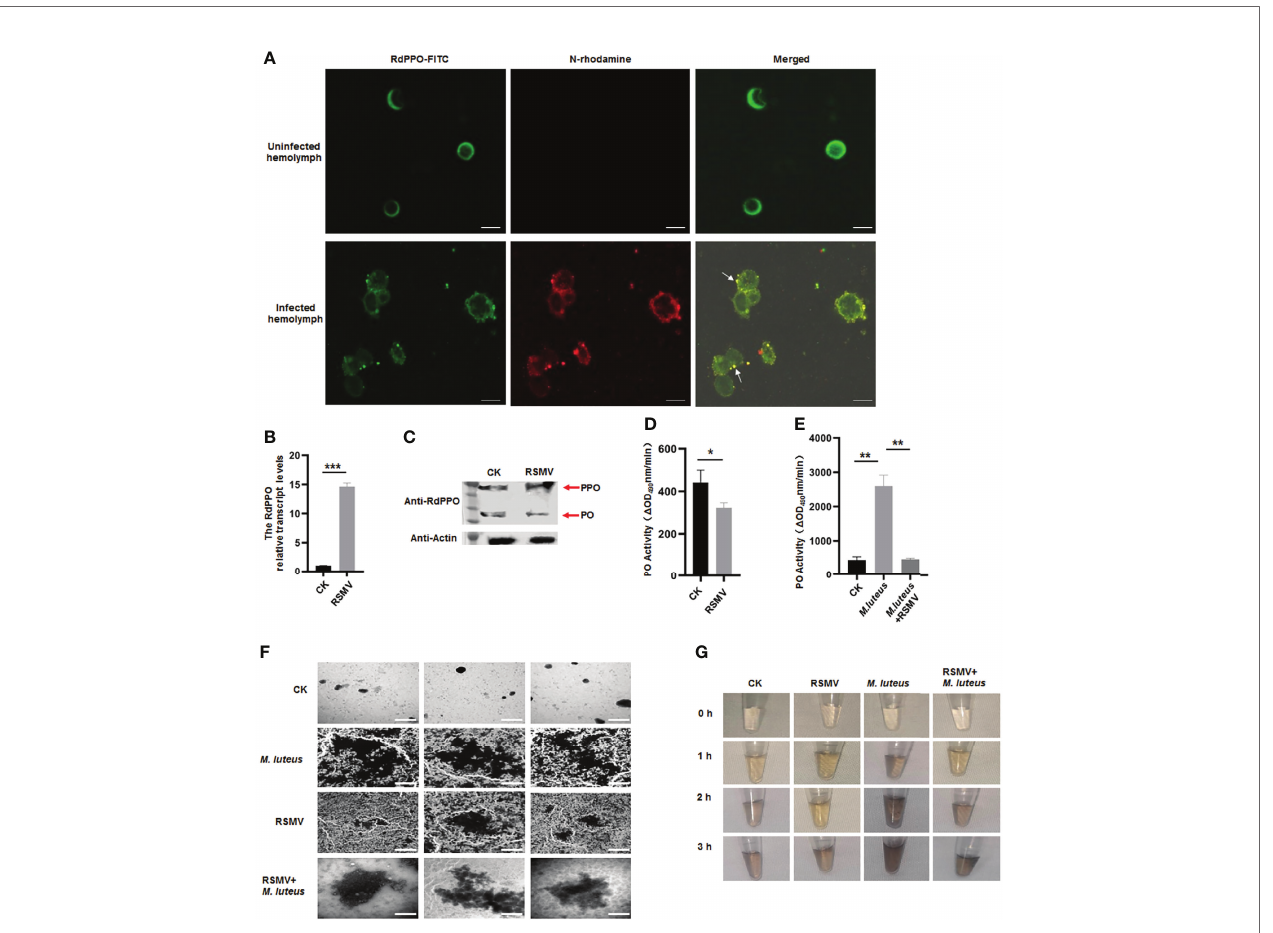
FIGURE 4 | Melanization is inhibited in RSMV infected leafhopper. (A) RdPPO and N distribution in hemolymph cells of RSMV-infected R. dorsalis . Hemolymph cells collected from viruliferous R. dorsalis were subjected to an immunolabeling assay with anti-RdPPO antibody conjugated with FITC (green) and anti-N antibody with rhodamine (red) and observed by confocal microscopy observation. Scale bars, 5 m m. (B) Transcript levels of PPO in RSMV-infected or healthy R. dorsalis detected by RT-qPCR normalized to the transcript levels of the internal control Actin gene. (C) The abundance of PPO and PO in viruliferous and nonviruliferous R. dorsalis detected by immunoblotting. RdPPO-speci fi c antibody was used to detect RdPPO and RdPO proteins. The abundance of R. dorsalis Actin, detected with actin antibody, was used as the control. Red arrows indicate the RdPPO and RdPO bands. (D) PO activity in the hemolymph of RSMV-infected and nonviruliferous R. dorsalis . Adult insects were punctured and their hemolymph examined for PO activity. PO activity was strongly reduced in viruliferous R. dorsalis compared to the nonviruliferous controls. (E) PO activity in nonviruliferous or viruliferous Recilia dorsalis infected with M. luteus . The control group was injected with PBS. (F) Transmission electron microscopy images showing the varied morphology of melanin produced in hemocytes of leafhoppers infected with M. luteus , RSMV, or RSMV/ M. luteus . Scale bars, 2 µm. (G) In vitro spontaneous melanization assay of hemolymph from leafhoppers subjected to different treatments. Hemolymph was collected from R. dorsalis infected with M. luteus , RSMV, or RSMV/ M. luteus and subjected to an in vitro spontaneous melanization assay. Melanin production was recorded by photography at different time points from 0 to 5 h. *P < 0.05; **P < 0.01; ***P <